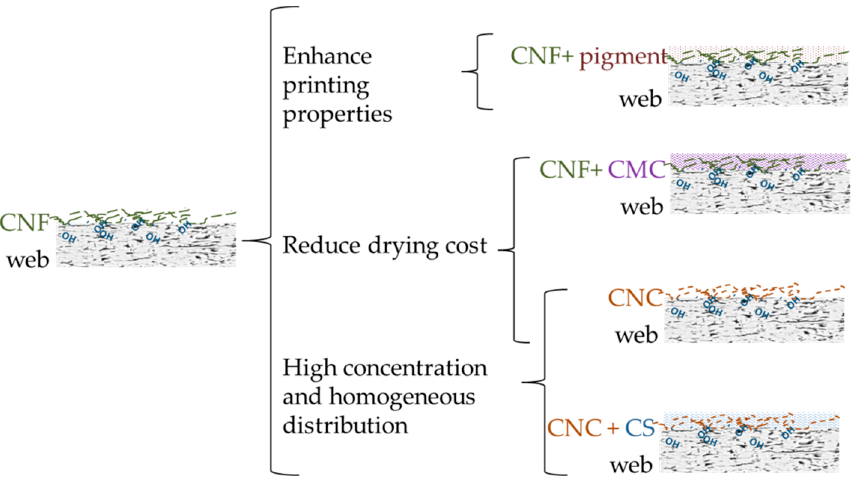
Figure 2. Some strategies in NC surface application (CMC: Carboxymethyl cellulose; CS: Cationic starch).